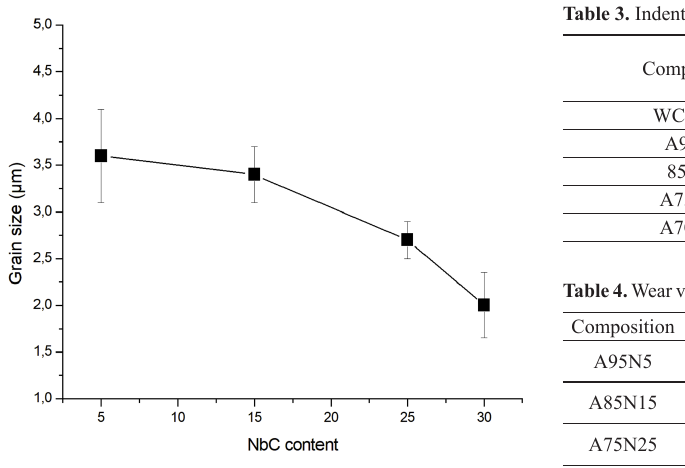
Figure 2. Grain size as a function of NbC content.